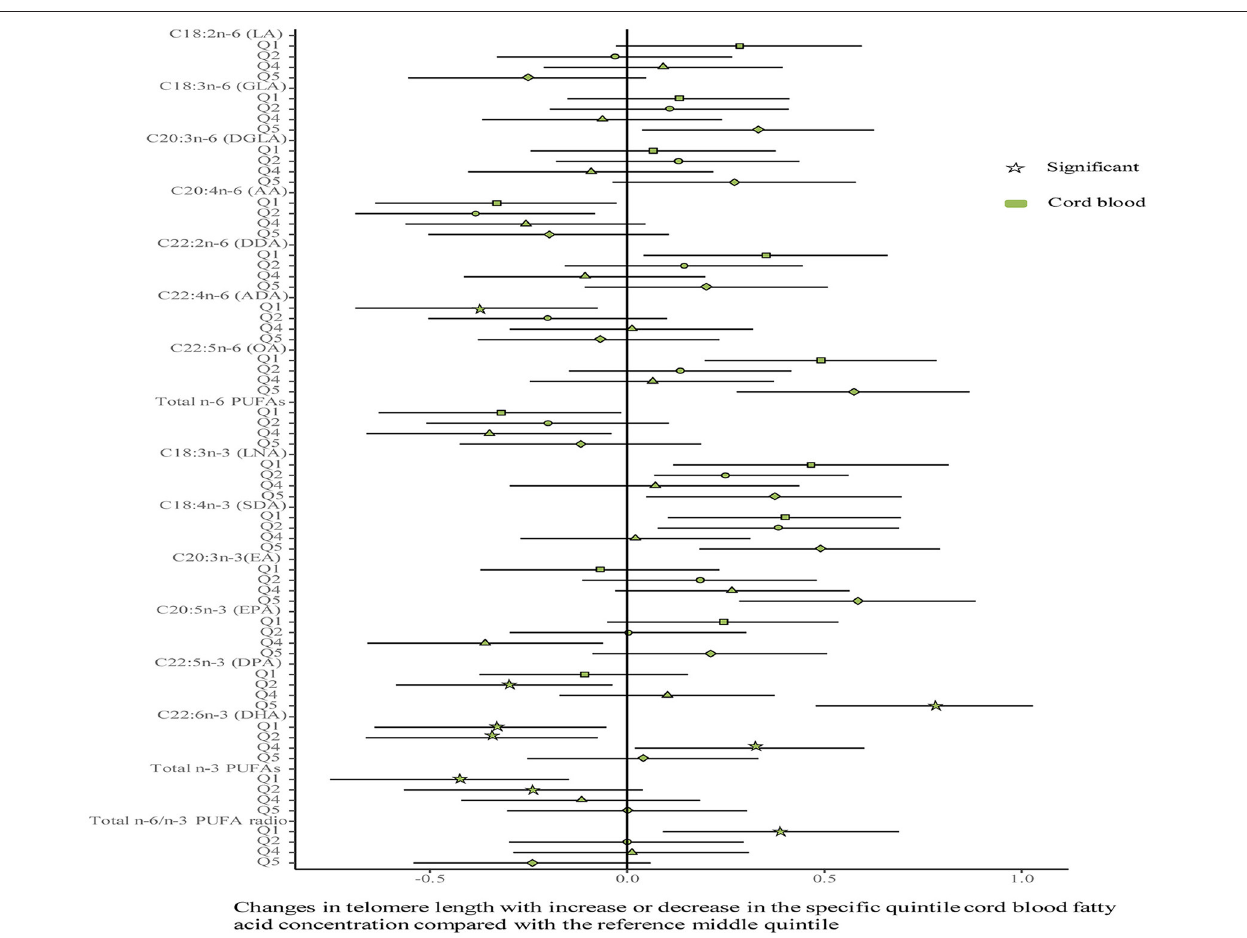
FIGURE 4 | Associations between fatty acids and TL in the cord blood. The categorical model is used to include quintiles as categorical concentrations of fatty acids. Quintiles are performed as a measure of maternal fatty acids concentration with the middle quintile as a reference (see Supplementary Table 4 ) to determine the potential nonlinearity of the association, with the quintiles as independent variables and TL as dependent variables. β -coefficients and 95% CI are adjusted for gestational age at birth, infant sex, birth weight and length, and maternal age, maternal prepregnancy BMI, and gestational weight gain, and paternal age and BMI, and represent differences between TL in the specific quintile and that in the reference middle quintile. Star: significant; color green: the cord